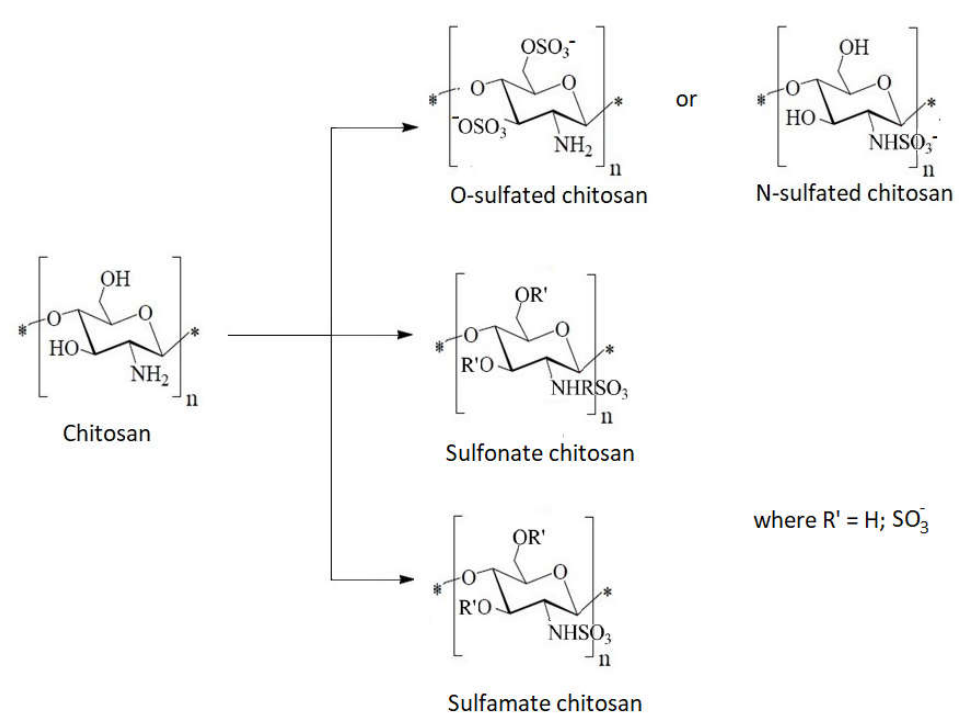
Figure 15. Schematic of chitosan sulfonation via thiourea. 4. Grafting of sulfonic groups onto chitosan (Figure 16)